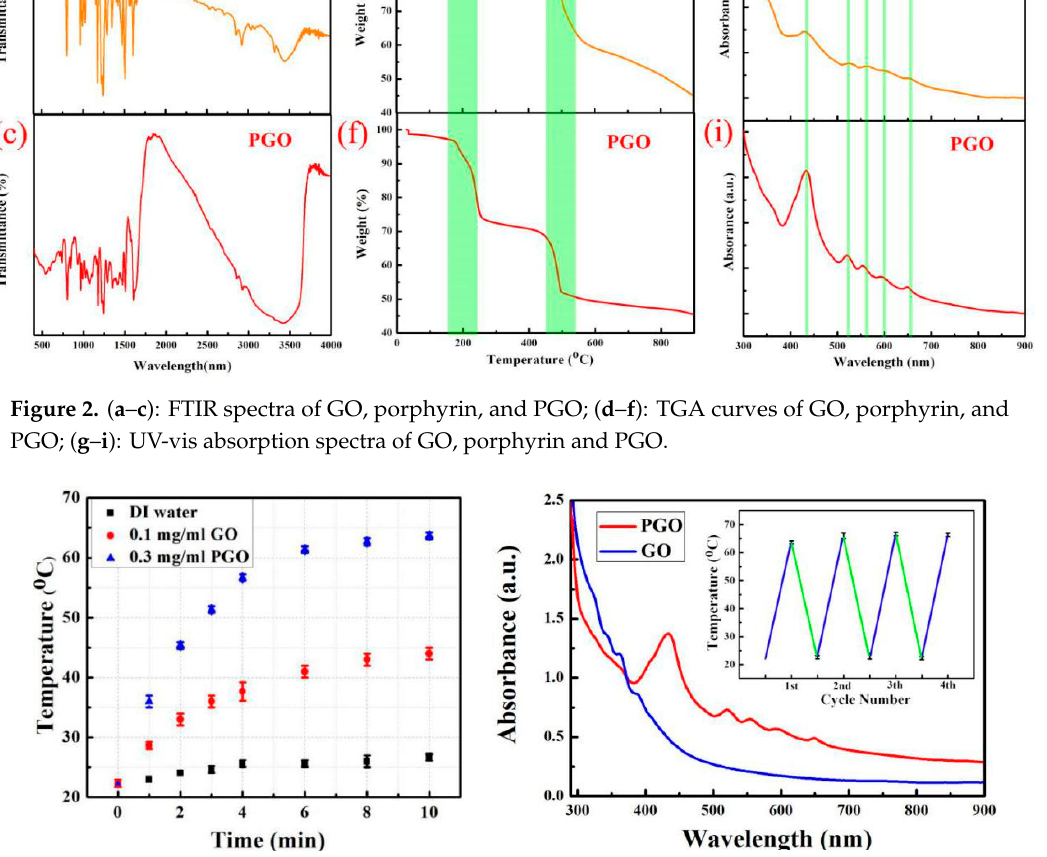
Figure 2. ( a – c ): FTIR spectra of GO, porphyrin, and PGO; ( d – f ): TGA curves of GO, porphyrin, and PGO; ( g – i ): UV-vis absorption spectra of GO, porphyrin and PGO.